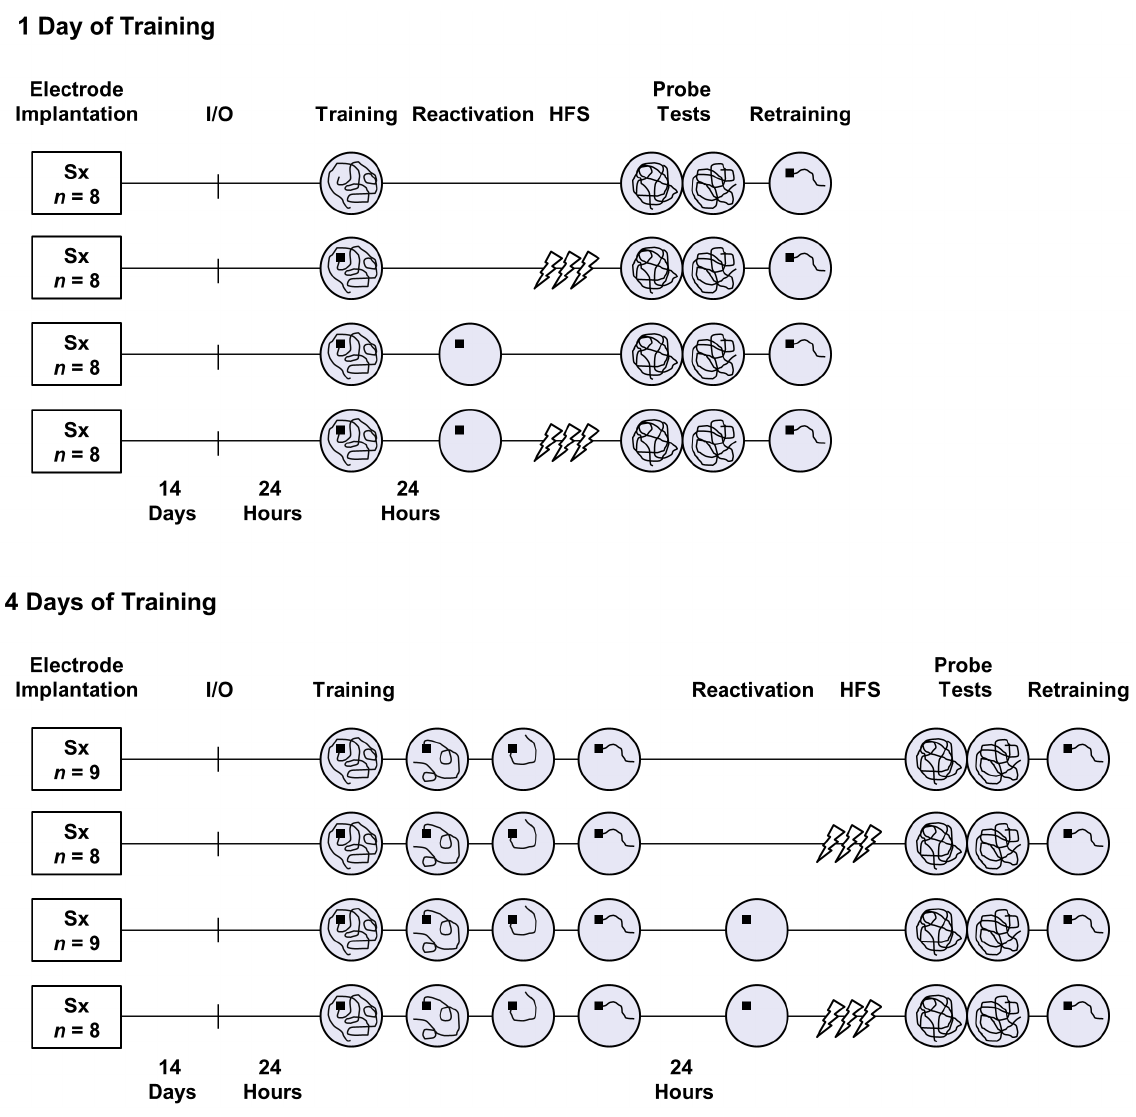
Figure 1. Experimental design and timeline. Rats were surgically (Sx) implanted with stimulating electrodes in the perforant path and recording electrodes in the dentate gyrus. After the acquisition of I/O curves, rats underwent either 1 day (upper timelines) or 4 consecutive days (lower timelines) of training in the hidden platform version of the Morris water task. Twenty-four hours after the completion of training, half of the rats received a memory reactivation treatment consisting of being briefly placed on the platform in its trained location in the pool (reactivation group), whereas the other half remained in their home cages (no reactivation group). Next, half of the rats received 10 HFS trains applied bilaterally to the perforant path (HFS group), whereas the other half received a matching number of test pulses (control group). Afterward, rats’ memory for the platform location was assessed during two consecutive probe tests with the platform removed from the pool. Finally, rats underwent retraining with the platform returned to its trained